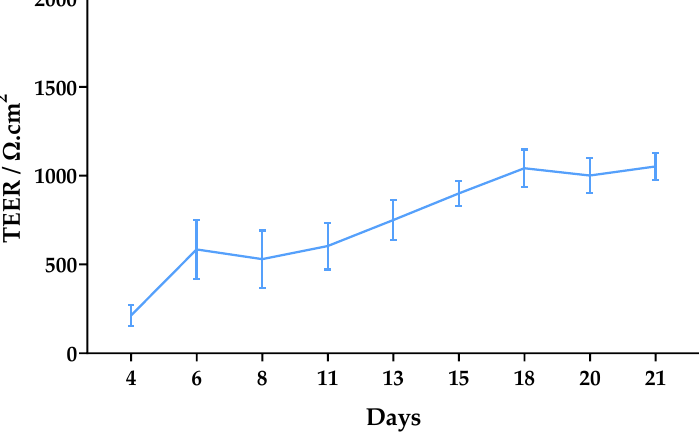
Figure 6. Monitoring of TEER values from day 4 to day 21 after seeding of Caco-2 cells. Results are expressed as mean ± SD obtained from three independent experiments.